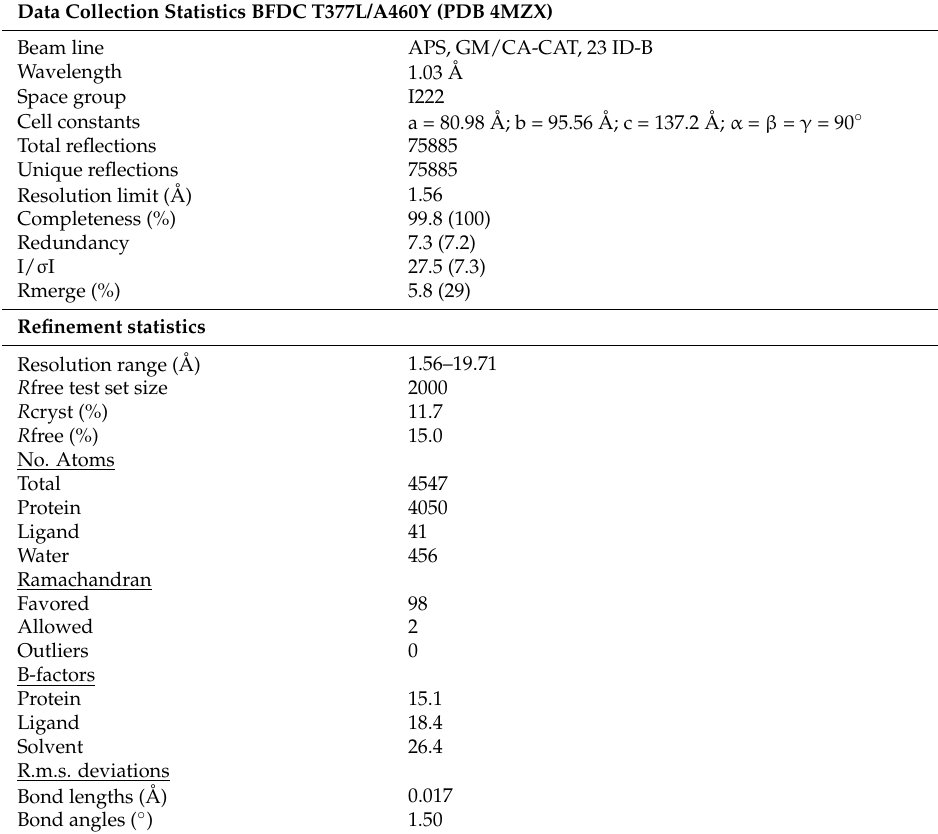
Table 3. Data, model, and crystallographic statistics for BFDC T377L/A460Y structure a .